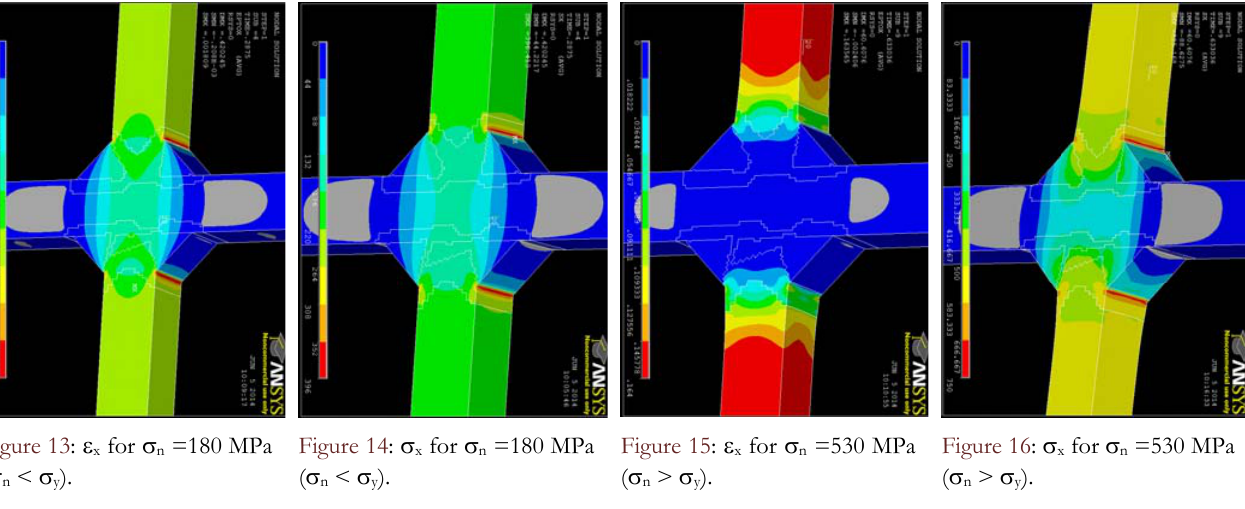
Figure 13:  x for  n =180 MPa (  n <  y ).